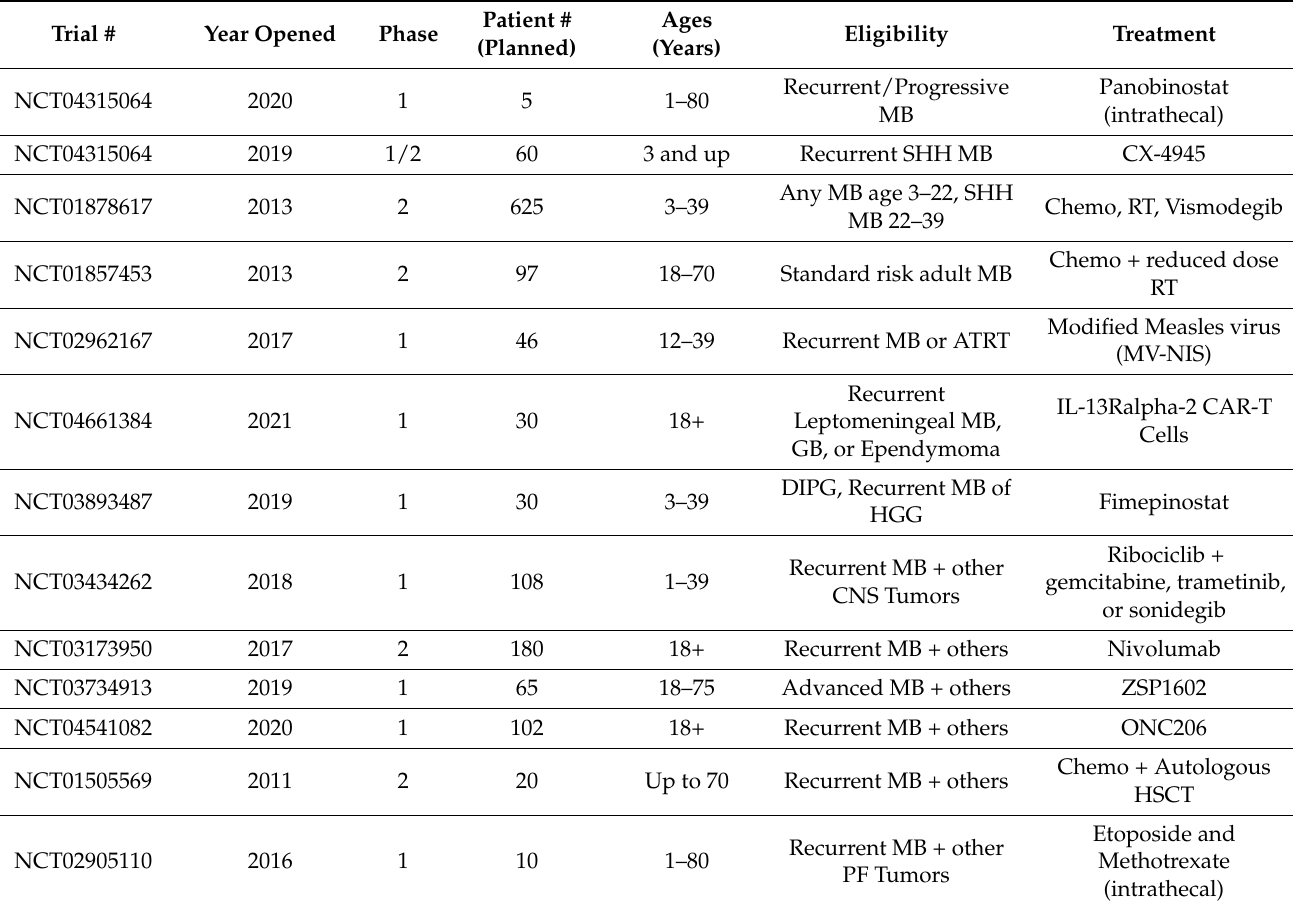
Abbreviations: Trial #: National Clinic Trial number from ClinicalTrials.gov, Patient #: Number of planned patients to be enrolled, MB: Medulloblastoma, RT: Radiation Therapy, MV-NIS: Measles Virus Sodium Iodide Symporter, GB: Gliobastoma, CAR-T: Chimeric antigen Receptor T-cell, ATRT: Atypical Teratoid Rhabdoid Tumor, DIPG: Diffuse Intrinsic Pontine Glioma, HGG: High-Grade Glioma, HSCT: Hematopoietic Stem Cell Transplant, PF: Posterior